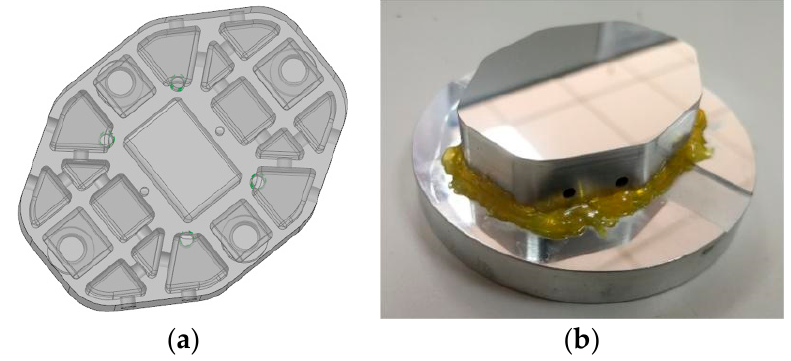
Figure 18. Internal lightweight structure ( a ) and mirror sample ( b ) [37].